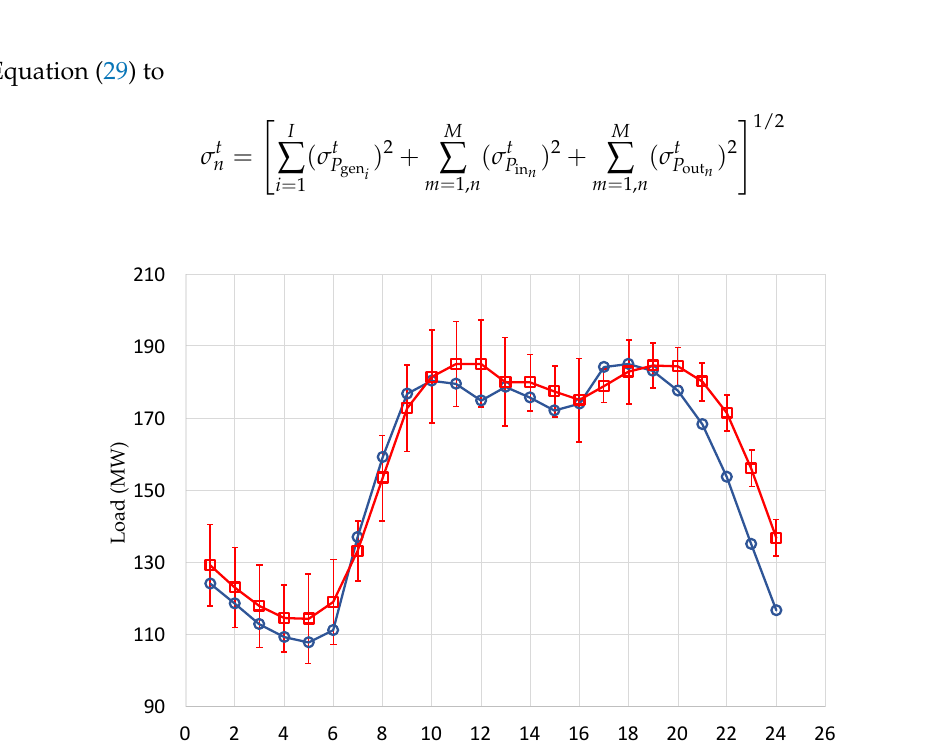
Figure 3. Load profiles for Scenario 1 (– ◦ – blue) and for Scenario 2 and Scenario 3 (– (cid:3) – red)